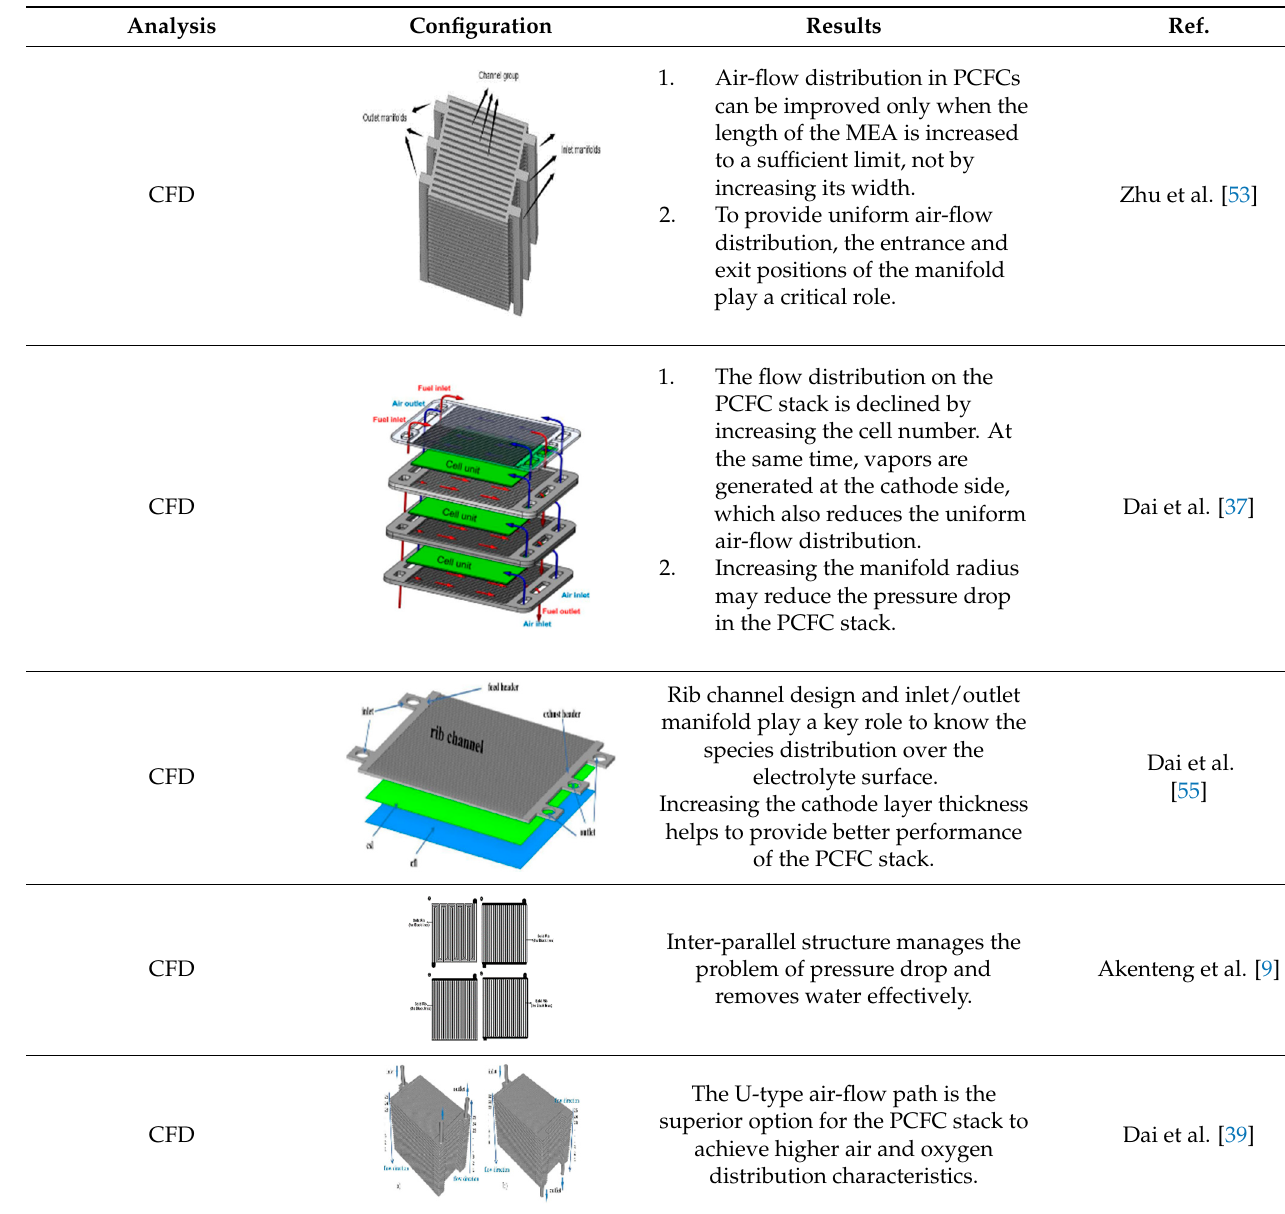
Table 2. List of the configuration employed in the recent models of PCFC stacks.